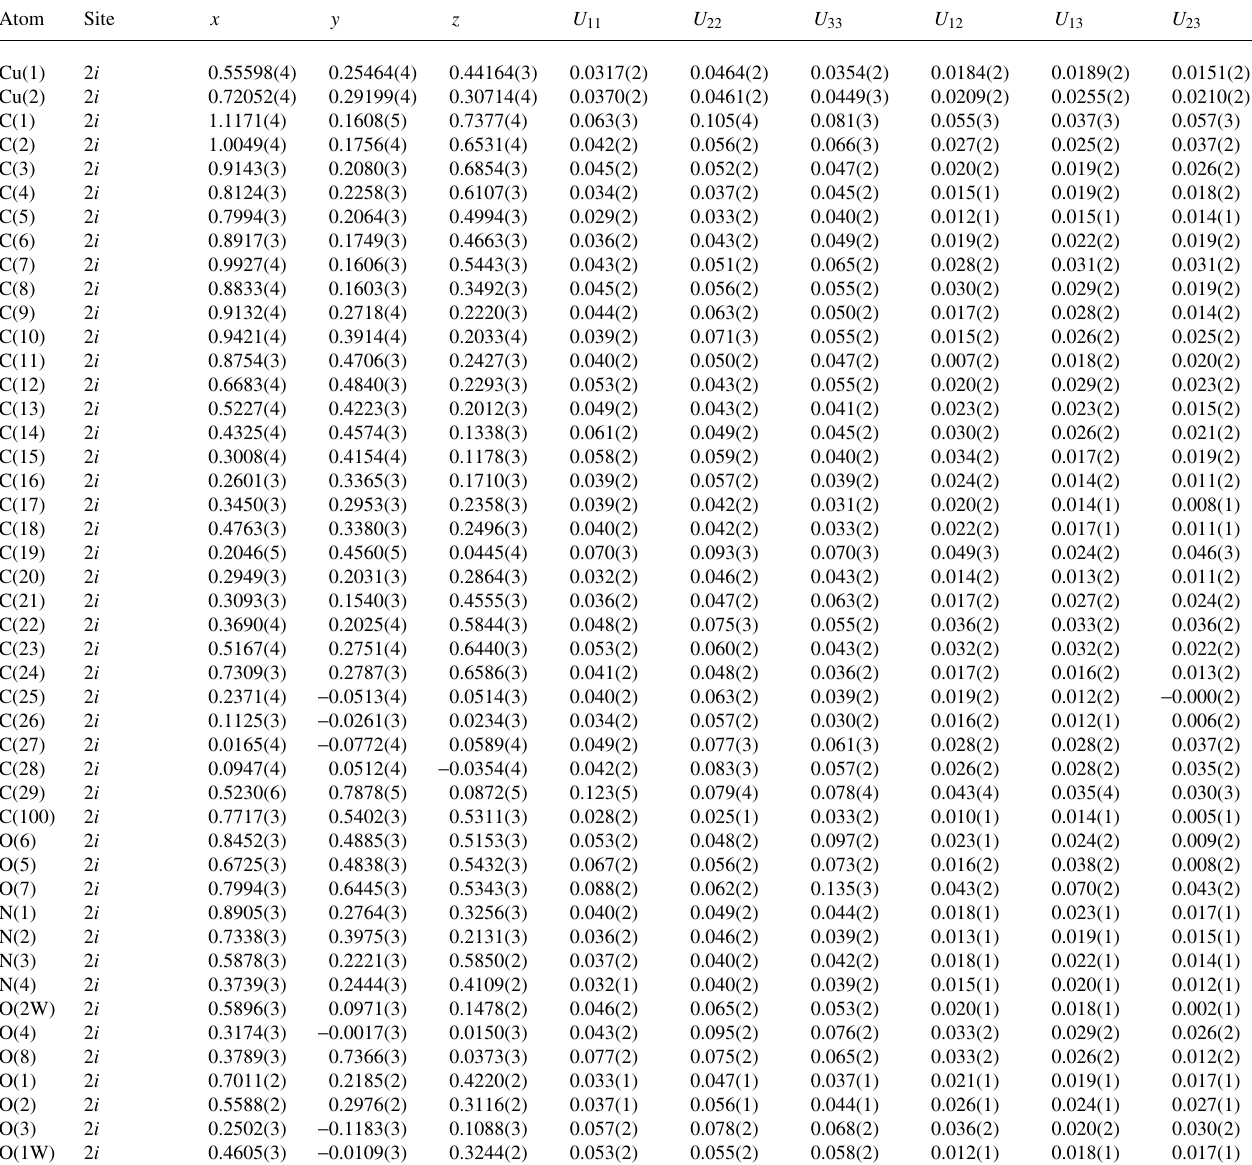
Table 3. Atomic coordinates and displacement parameters (in Å 2 )